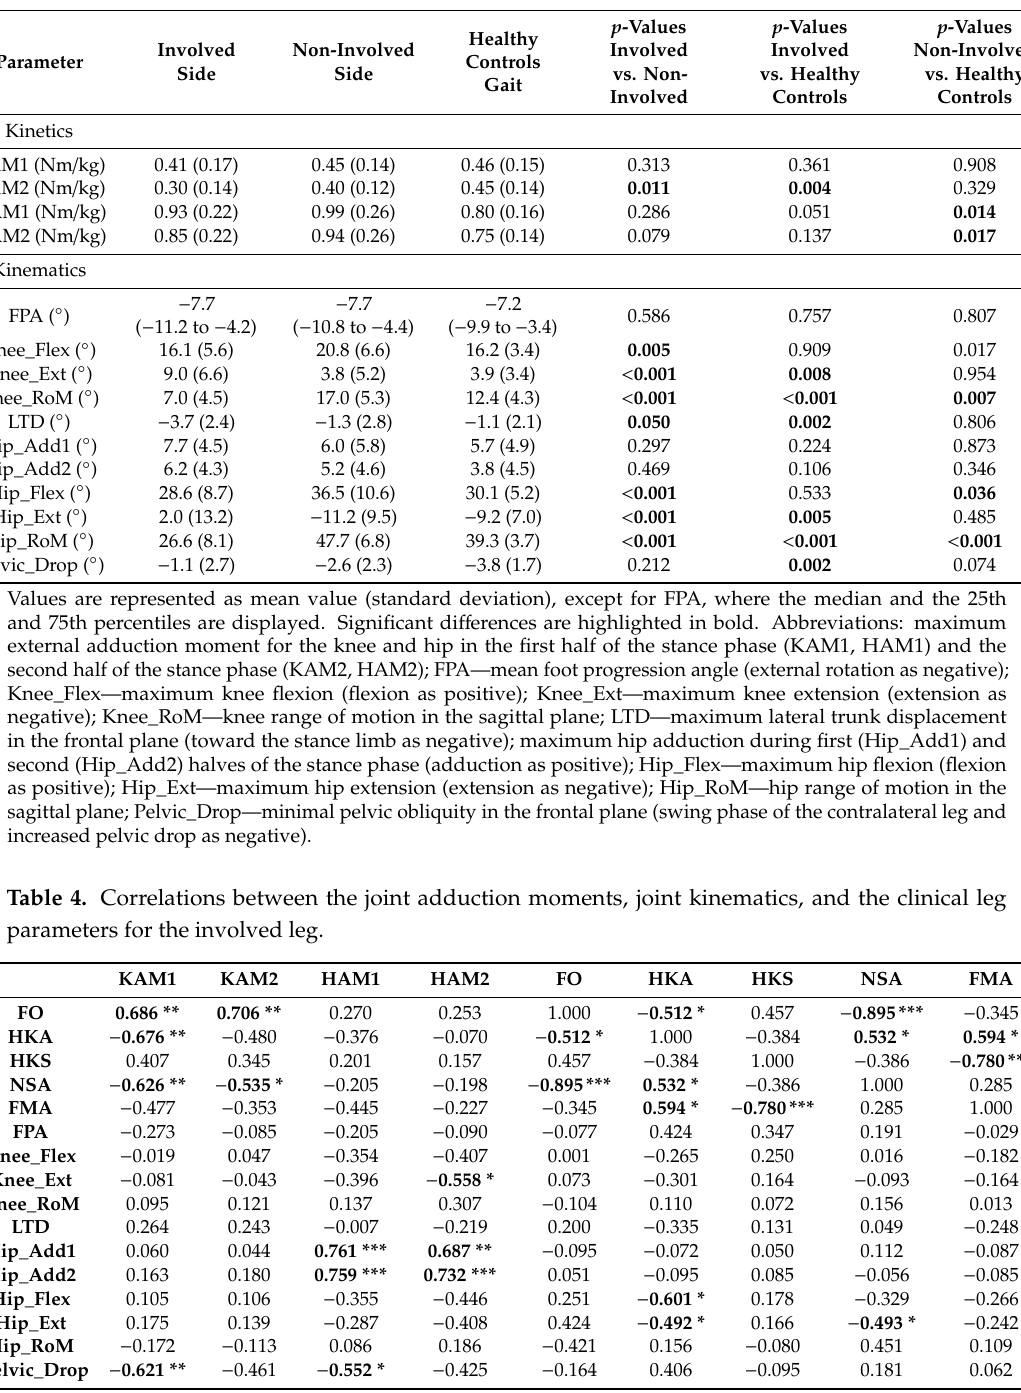
Table 3. Kinetics and kinematics during the stance phase of gait for both the involved and non-involved sides and for healthy controls.